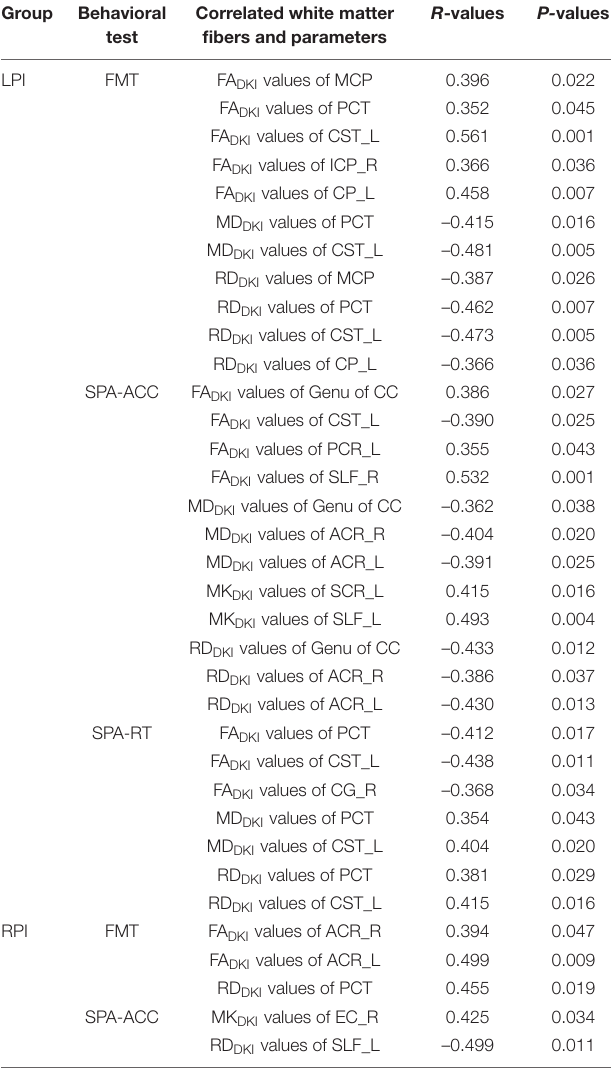
TABLE 6 | Correlations between DKI parameters and behavioral scores in PI patients. Group Behavioral